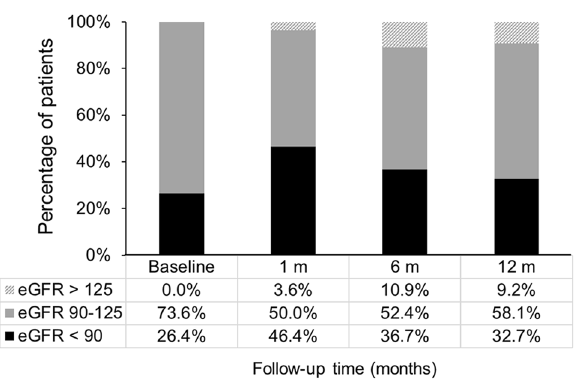
Figure 1. Incidence of renal impairment, defined as estimated glomerular filtration rate (eGFR) of < 90 mL/ min/1.73 m 2 , at baseline, 1-, 6-, and 12-month following laparoscopic sleeve